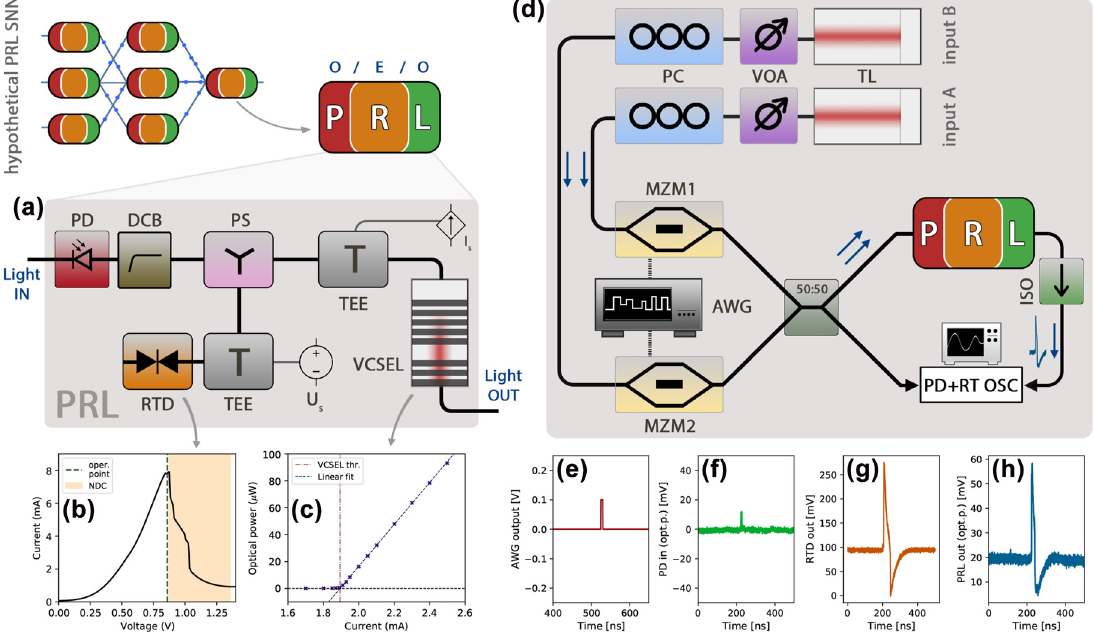
Figure 1: Overview of the spiking optoelectonic neuron layout, components, experimental setup and dynamics. (a) Component layout of the coupled to a fiber-coupled VCSEL biased at I . PD, photodetector; PRL node, including the RTD element with independently tuneable bias U s s DCB, DC blocking element; PS, resistive power splitter; TEE, a bias tee; RTD, resonant tunnelling diode. (b) I – V characteristics of the RTD, with region of negative differential conductance (NDC) highlighted in orange. RTD is operated in region around 860 mV. (c) L – I curve of the output (transmitter) VCSEL. (d) The dual-channel (fan-in) experimental setup with optical timetrace readout on the RT OSC. TL, tuneable laser; VOA, variable optical attenuator; PC, polarisation controller; MZM, Mach–Zehnder modulator; AWG, arbitrary waveform generator; ISO, optical isolator. (e) Example of spike triggering perturbation (waveform from AWG). (f) Trace of optical power on input branch, RF-modulated via MZM and recorded on amplified photodetector (DC component is filtered). (g) An electrical spike, activated in a PD-RTD system. (h) An optical spike at the output